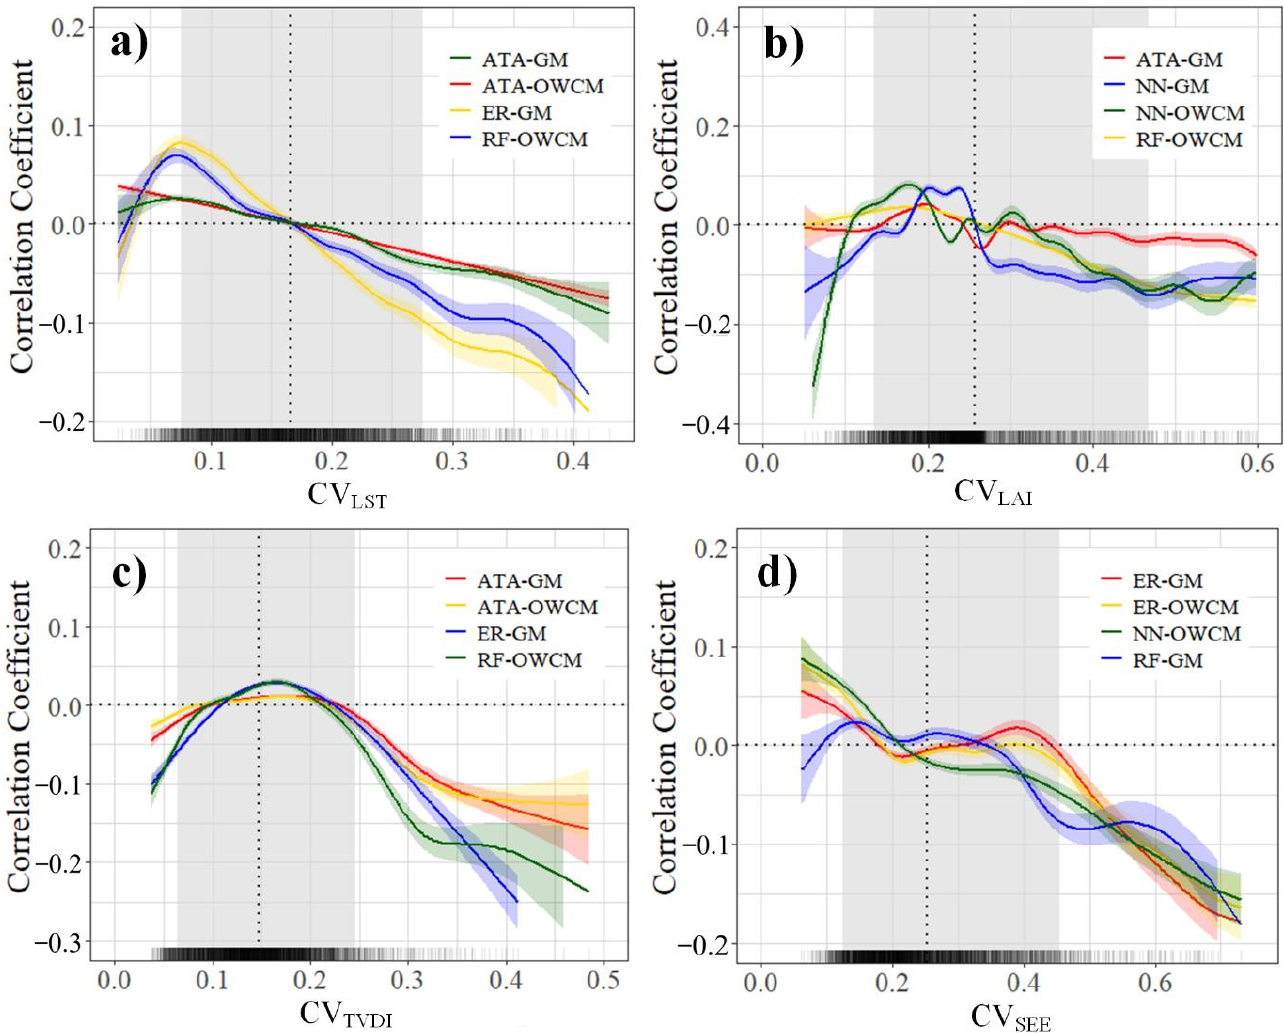
Figure 9. GAM partial effect splines presenting the dynamic changes in the fitting accuracy R with ( a ) CV LST , ( b ) CV LAI , ( c ) CV TVDI , and ( d ) CV SEE . In ( a – d ), the dotted lines indicate the zero value ( y -axis) and the means of explanatory variables ( x -axis), while the shaded areas are the 90% confidence intervals. Moreover, the small vertical lines at the bottoms of the figures represent data points.